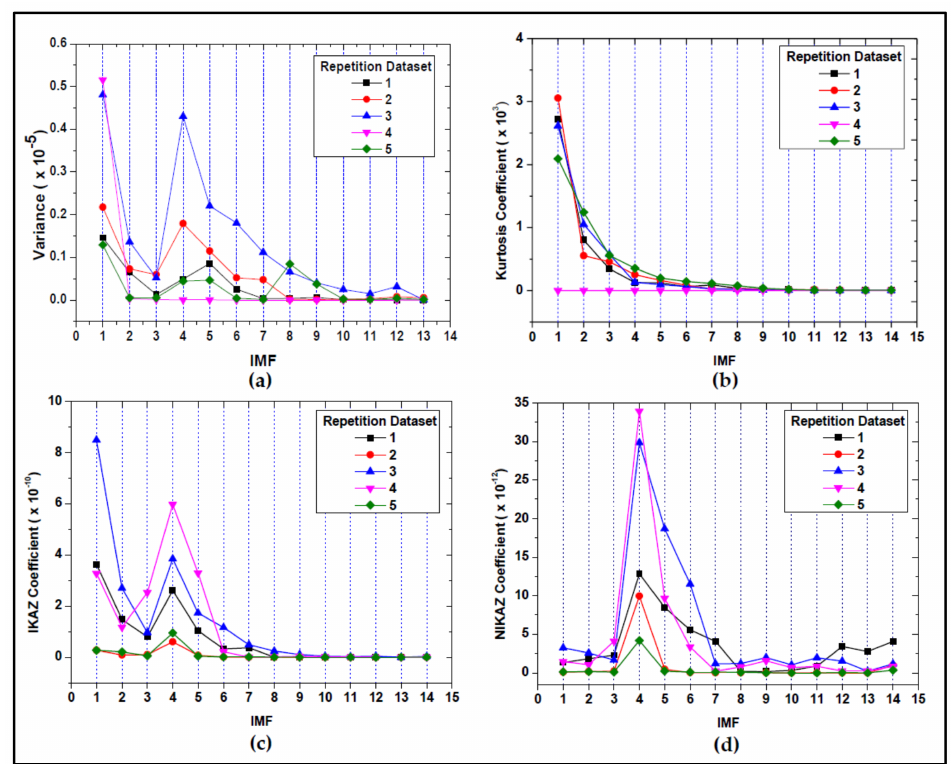
Figure 16. The curve for no-leak IMFs: ( a ) Variance, ( b ) Kurtosis, ( c ) IKAZ, ( d ) NIKAZ.